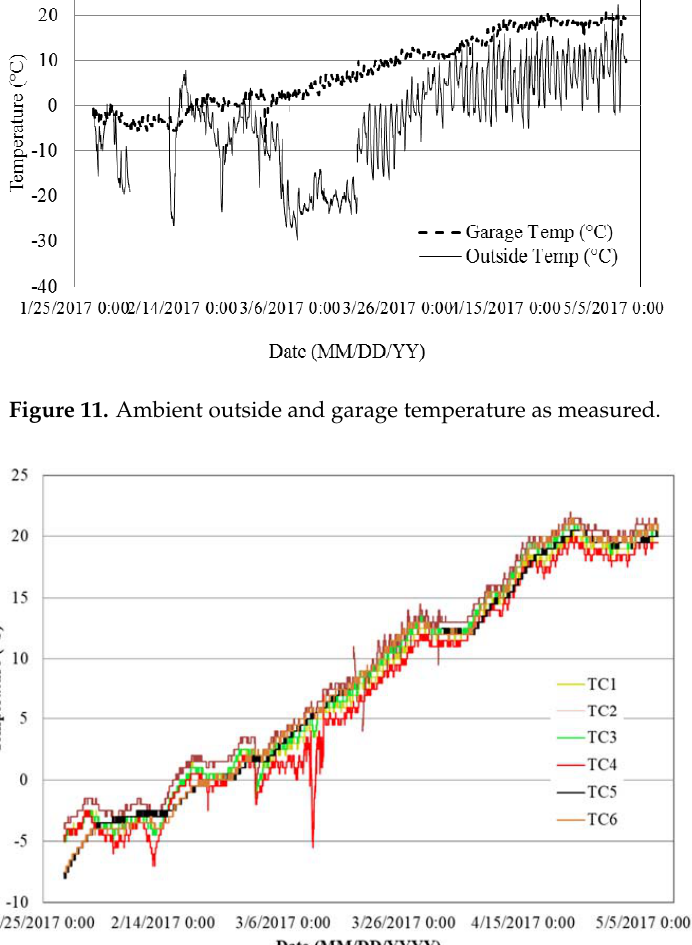
Figure 12. Temperature profile of each sand ‐ bed measurement location.